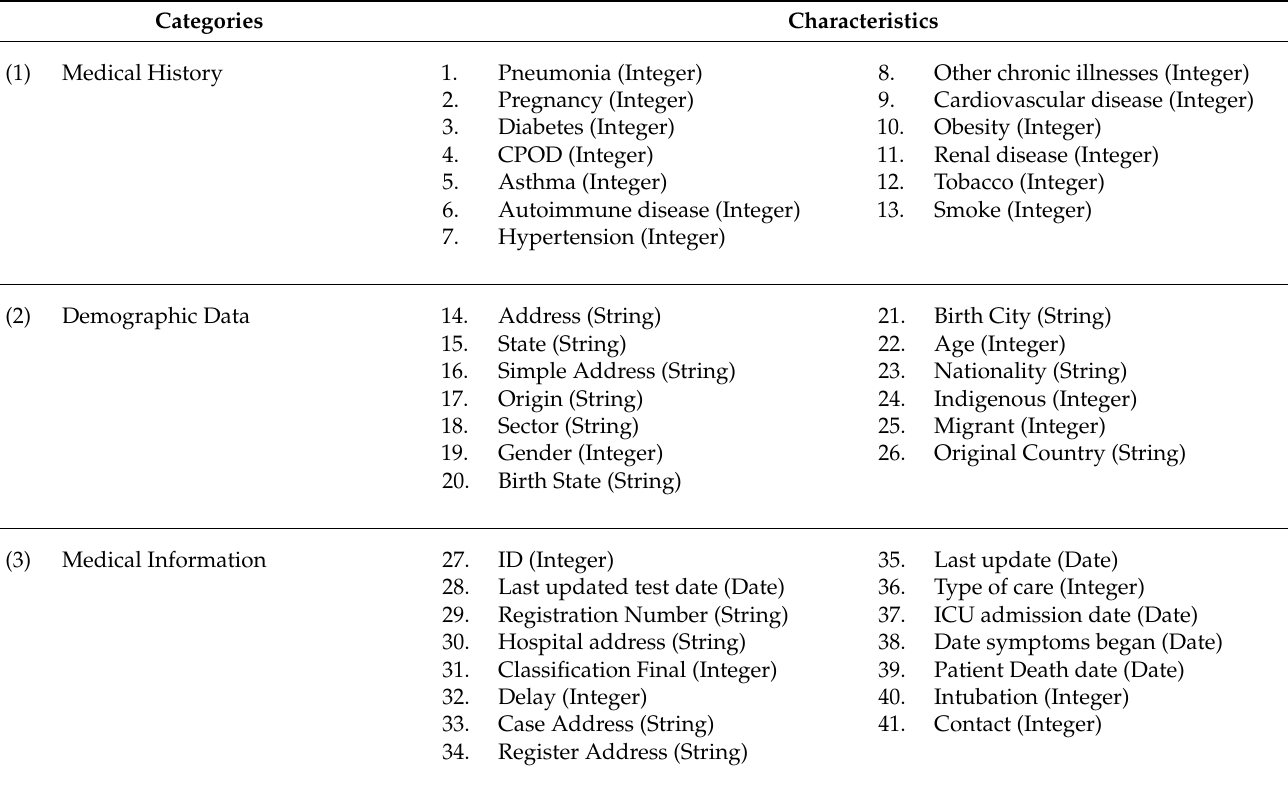
Table 2. List of attributes present in the Mexican COVID-19 dataset after converting to English (variable type is denoted in